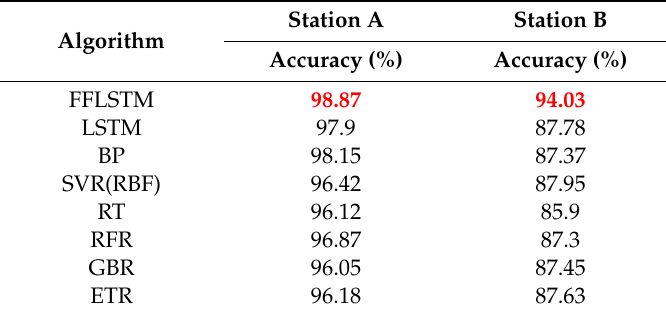
Table 9. The accuracy for the final prediction model.